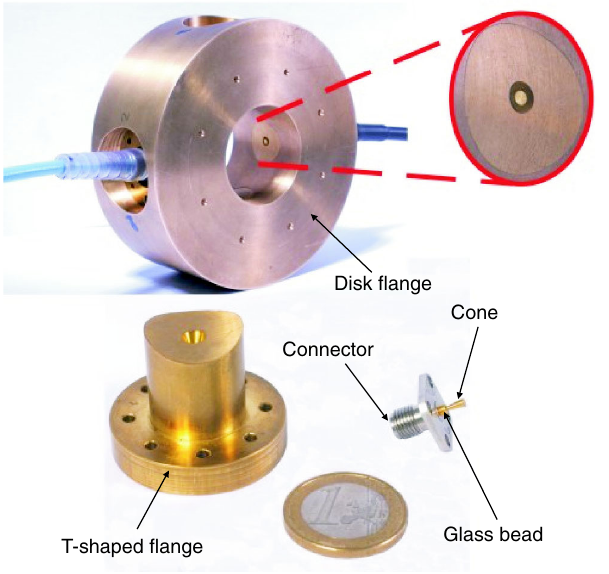
FIG. 5. Realization of a nonhermetic pickup prototype. Top: Pickup system with four integrated pickups. Bottom: Disassembled pickup element.